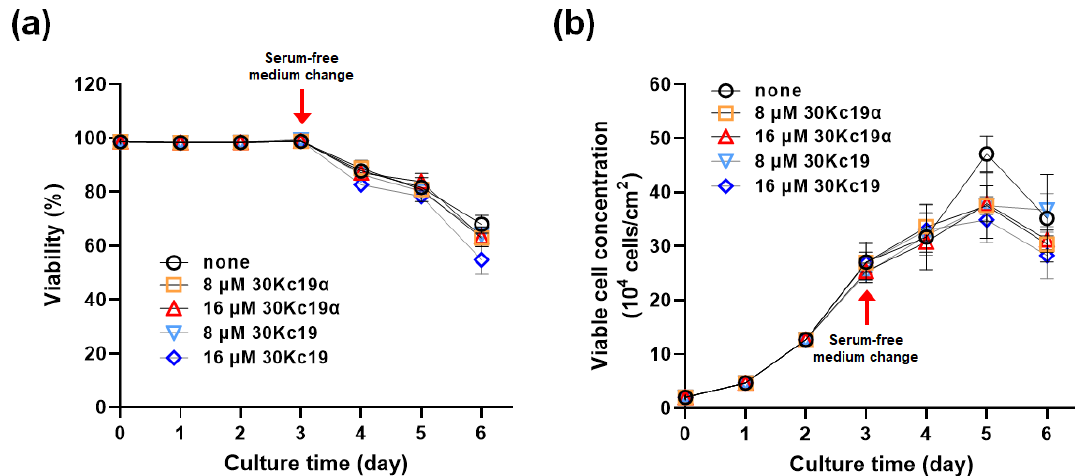
Figure 3. Effect of 30Kc19 α on viability and viable cell growth of CHO cells. After 48 h of incubation in a complete medium, EPO–CHO cells were treated with the indicated concentration of 30Kc19 α or 30Kc19 for a further 24 h in fresh complete medium. The medium was replaced with serum-free DMEM/F12 containing each protein. ( a ) Cell viability and ( b ) viable cell concentration of EPO–CHO cells before and after the medium change. Error bars indicate standard deviations ( n = 3 per group).